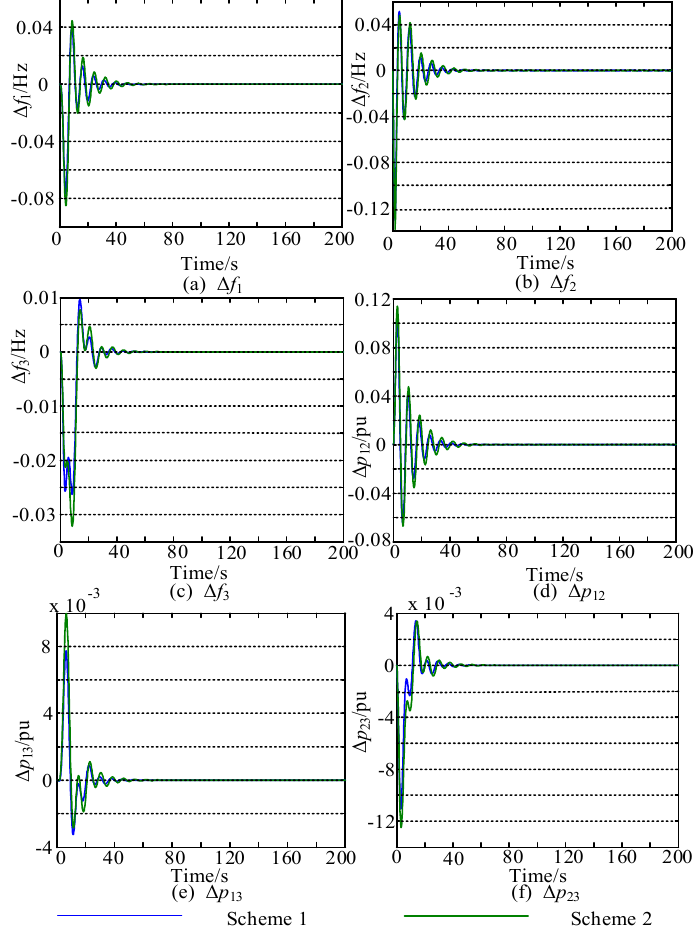
Figure 3. Results contrast curve under unconstrained: ( a ) frequency deviation of the first CA; ( b ) frequency deviation of the second CA; ( c ) frequency deviation of the third CA; ( d ) tie-line power deviation between the first and second CAs; ( e ) tie-line power deviation between the first and third CAs; ( f ) tie-line power deviation between the second and third CAs.